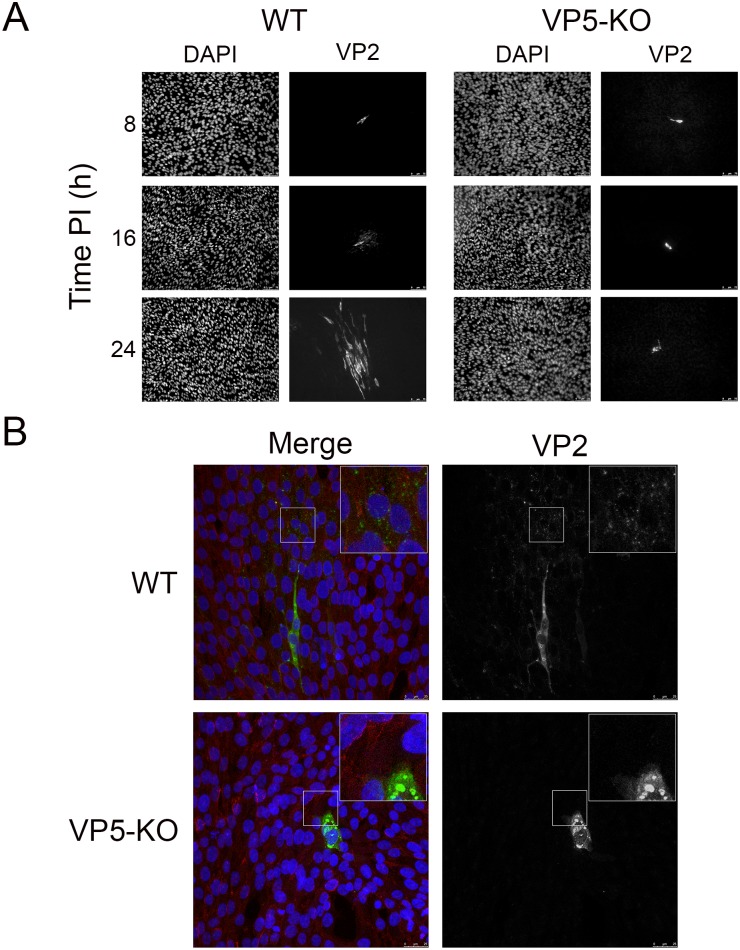
Effect of VP5 expression on IBDV dissemination.QM7 cell monolayers were infected at low MOI (0.005 PFU/cell) with the WT or the VP5-KO virus. After virus adsorption, cultures were washed twice with fresh medium to remove unbound virions, and covered with semi-solid medium. (A) Single-cell virus spreading. At the indicated times PI, the semi-solid medium was lifted and monolayers processed for immunostaining with anti-VP2 serum (VP2). Nuclei were stained with DAPI. Samples were then visualized by fluorescence microscopy. Fluorescence signals were recorded separately by using appropriate filters. Presented micrographs are characteristic examples of images recorded at the indicated times PI. Left- and right-hand panels show the DAPI and VP2 staining of the same culture areas, respectively. Bars correspond to 75 μm. (B) Visualization of virus release at single-cell level. Samples collected at 16 h PI were immunostained with anti-VP2 serum (green) and -Pan cadherin (red). Cell nuclei were stained with DAPI (blue). Samples were analyzed using confocal laser scanning microscopy. Left-hand panels show the overlay of the three fluorescent signals (Merge). Right-hand panels show the VP2 signal. Insets show a higher magnification (x2.5) of boxed areas. Bars correspond to 25 μm.